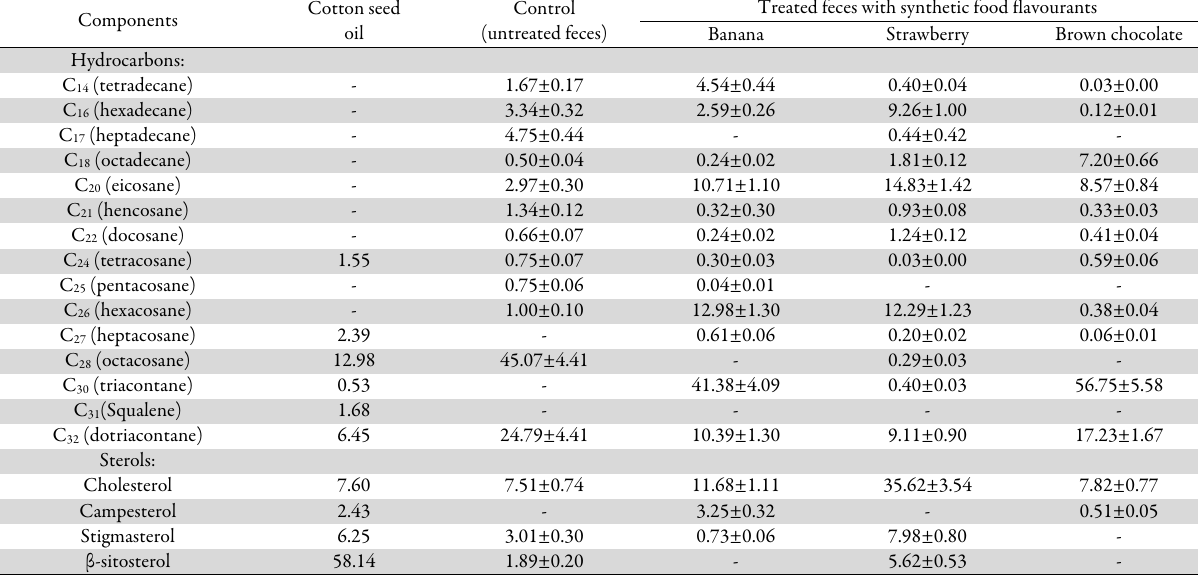
Table 6. Relative percentage of unsaponifiable matters in rat feces affected by synthetic food flavourants Treated feces with synthetic food flavourants Cotton seed Control Components oil (untreated feces) Banana Strawberry